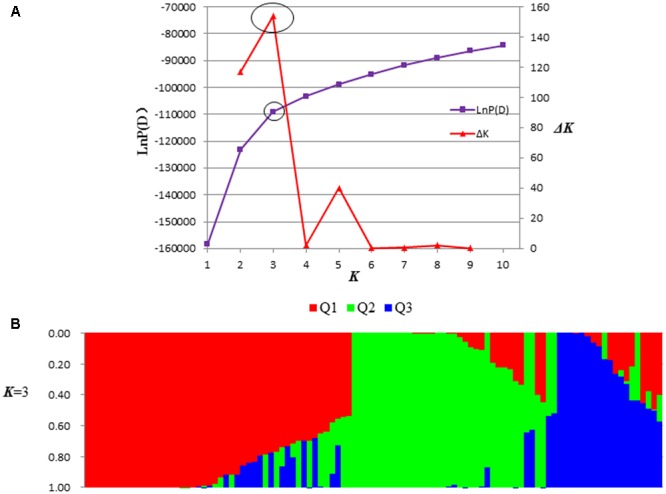
Population structure of the peanut panel. (A) Two different methods for determining the optimal value of K. The blue line indicated the ad hoc approach described by Pritchard et al. (2000). The red line indicated ΔK based on the change of LnP(D) between consecutive K and developed by Evanno et al. (2005). (B) The population structure in the peanut panel at K = 3.